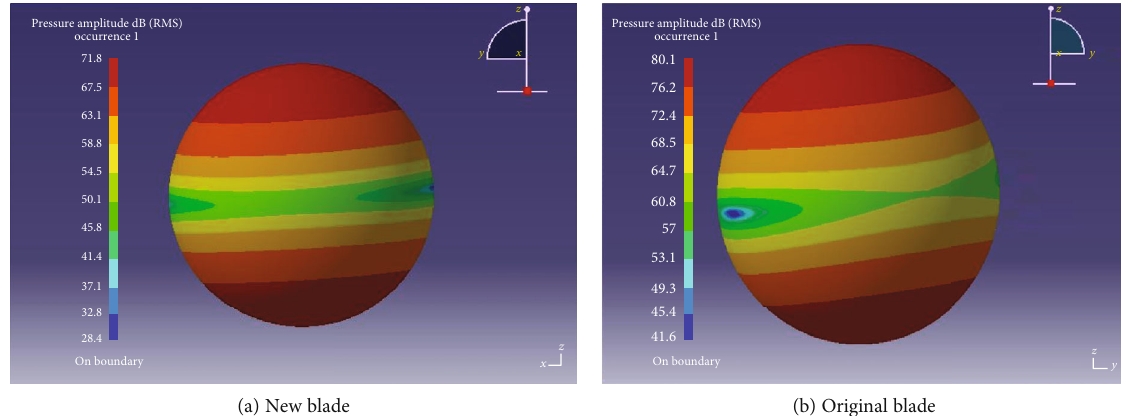
Figure 13: 2000 rpm spherical fi eld sound pressure